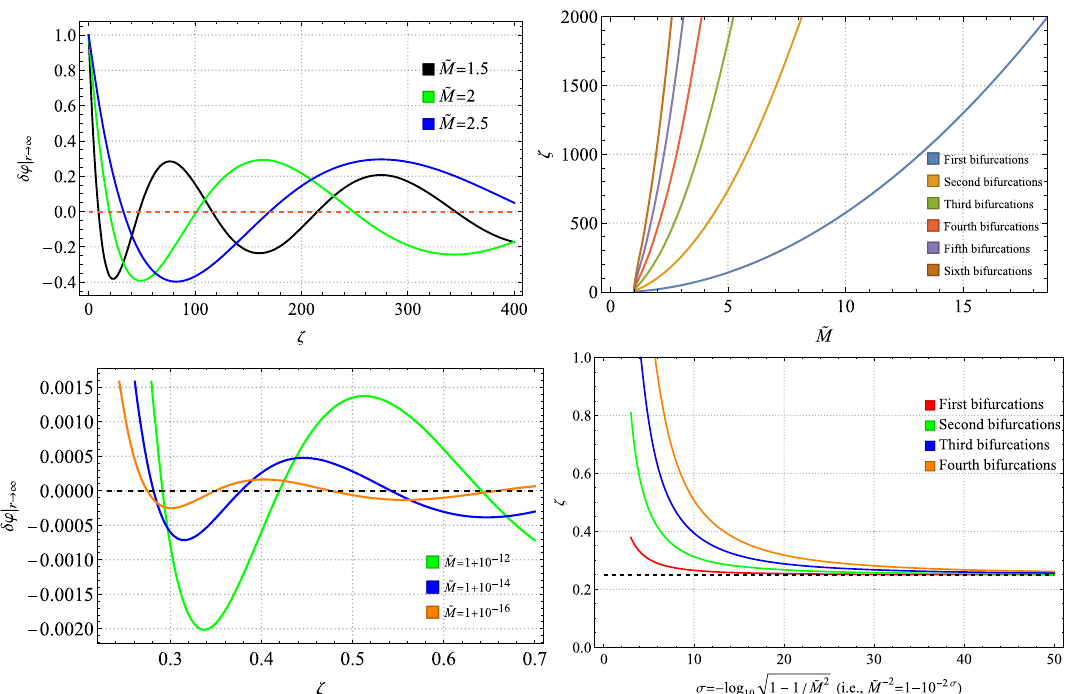
of the scalar field satisfying the asymptotic flatness condition) from the dyonic RN black hole, and the bottom right panel shows its behavior near the extremal black holes (i.e., ˜ M (cid:2)